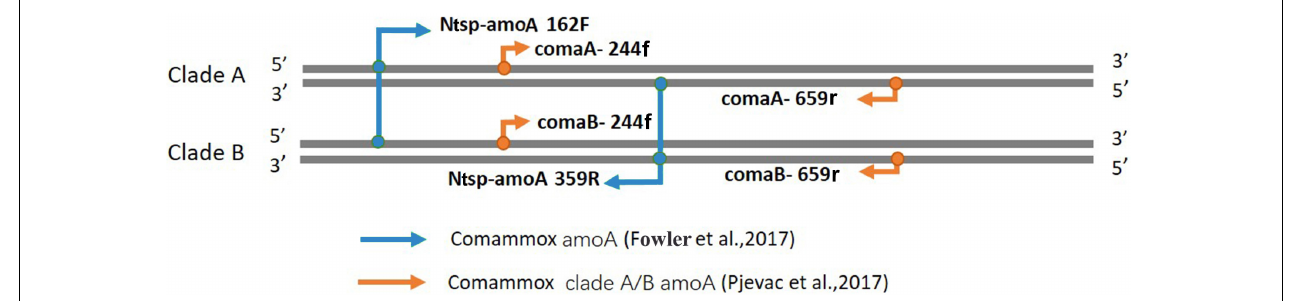
FIGURE 1 | Visual representation of primer-binding sites with comammox clade A amoA genes and comammox clade B amoA genes. The primer set comaA/B -244f/359r, labeled with orange arrows, are located between positions 244–261 and 643–659 in comammox amoA genes. The Amplification with primers Ntsp-amoA 162F/359R (blue arrows) occurs at binding regions between positions between 162–182 and 339–359. TABLE 1 | Properties of the comammox amoA-targeted primer sets used for PCR in this study. Target